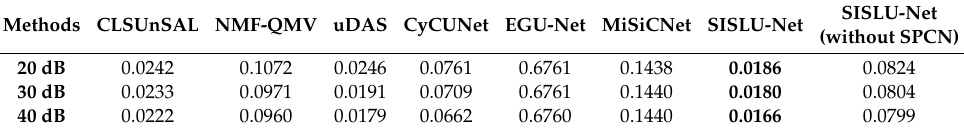
Table 3. Mean SAD of the Simulated Dataset. The best results are shown in bold.